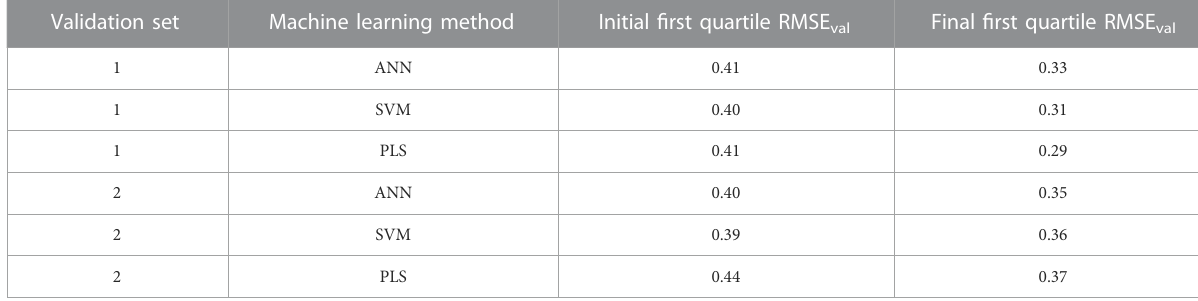
TABLE 4 Improvement of quality of individual validation set predictions by the evolutionary algorithm. Validation set